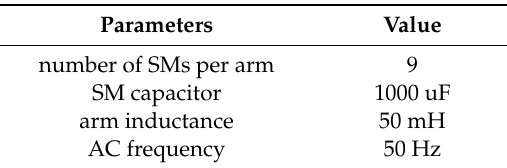
Figure 1. Structure of a three-phase modular multilevel converters (MMC) with half-bridge submodules. Table 1. Parameters of MMC.